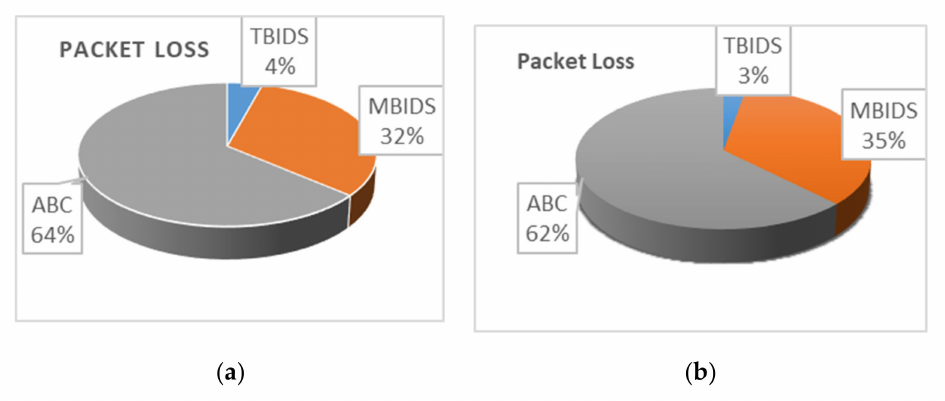
Figure 18. Packet loss ( a ) for small-scale networks, ( b ) for large-scale networks.